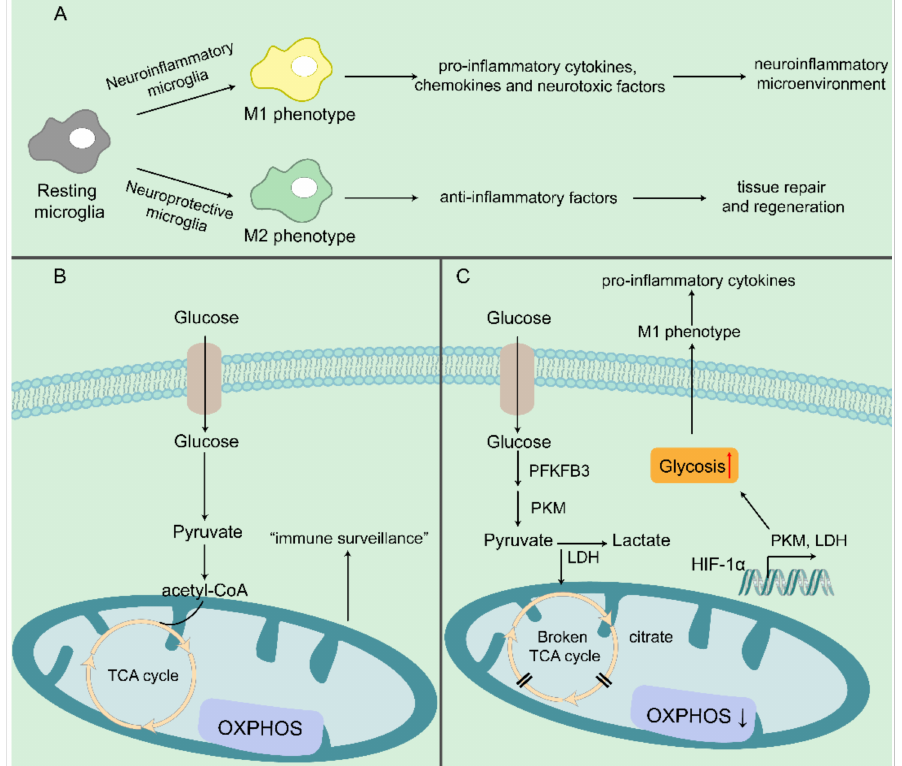
Figure 2. The role of microglia in neuroinflammation. ( A ) In a dichotomy model, the M1-type microglia typically express pro-inflammatory cytokines, chemokines and neurotoxic factors, while the M2-type microglia generally produce anti-inflammatory, neuroprotective and wound-healing factors. ( B ) In the healthy brain, microglia are metabolically flexible and can use glucose to support homeostatic “immune surveillance” functions. ( C ) Under pathological conditions, such as AD, mi- croglia display a metabolic reprogramming featured by broken TCA cycle. HIF1 α , hypoxia inducible factor-1 α ; PKM, Pyruvate kinase isozyme typeM2; PFKFB3, phosphofructokinase-2/fructose-2,6- bisphosphatase 3; OXPHOS, Oxidative phosphorylation; LDH, lactate dehydrogenase. Brown rectangle: glucose transporter; yellow cycle: TCA cycle; purple rectangle: oxidative phosphorylation; orange rectangle: increased